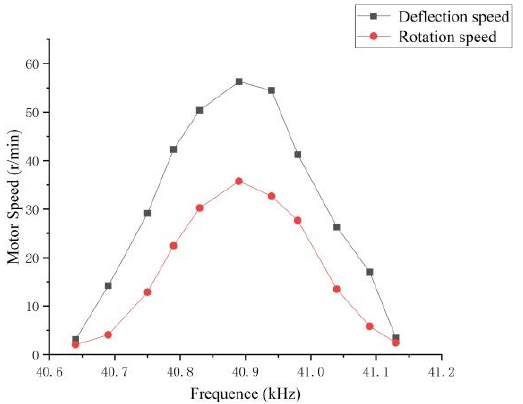
Figure 16. Motor speed curve.